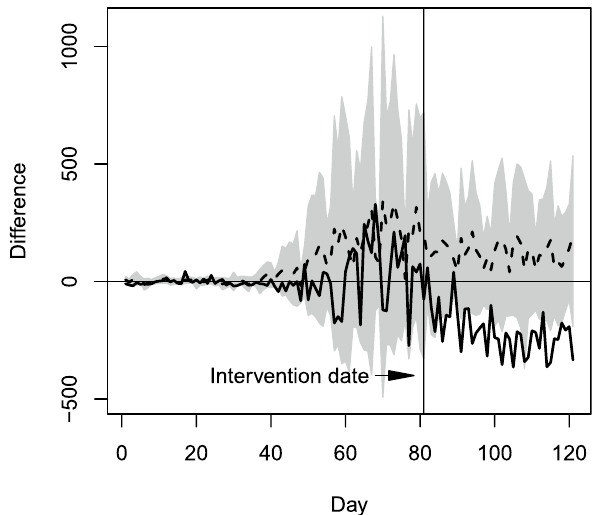
Figure 3. Differences between new cases in treatment and synthetic control regions over time, obtained by running the synthetic control method for each of the 21 Italian regions. The solid line corresponds to South Tyrol, the dashed line represents point-wise average difference for the remaining regions, the shaded area represents points within 1.96 standard deviations from the point-wise average